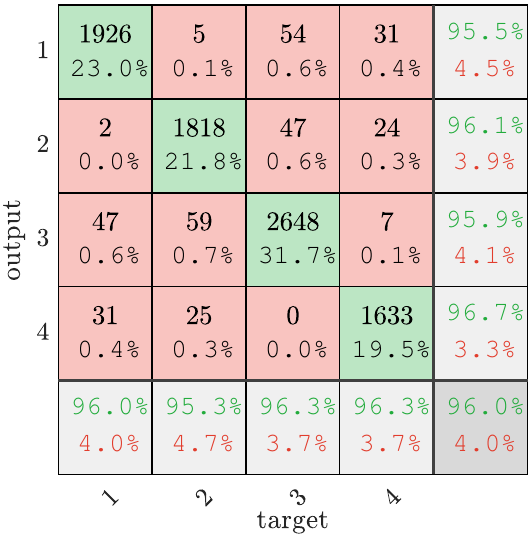
Figure 3. Mixed-gas-identification confusion matrix. ‘1’ is methane, ‘2’ is ethylene, ‘3’ is air, and ‘4’ is mixed